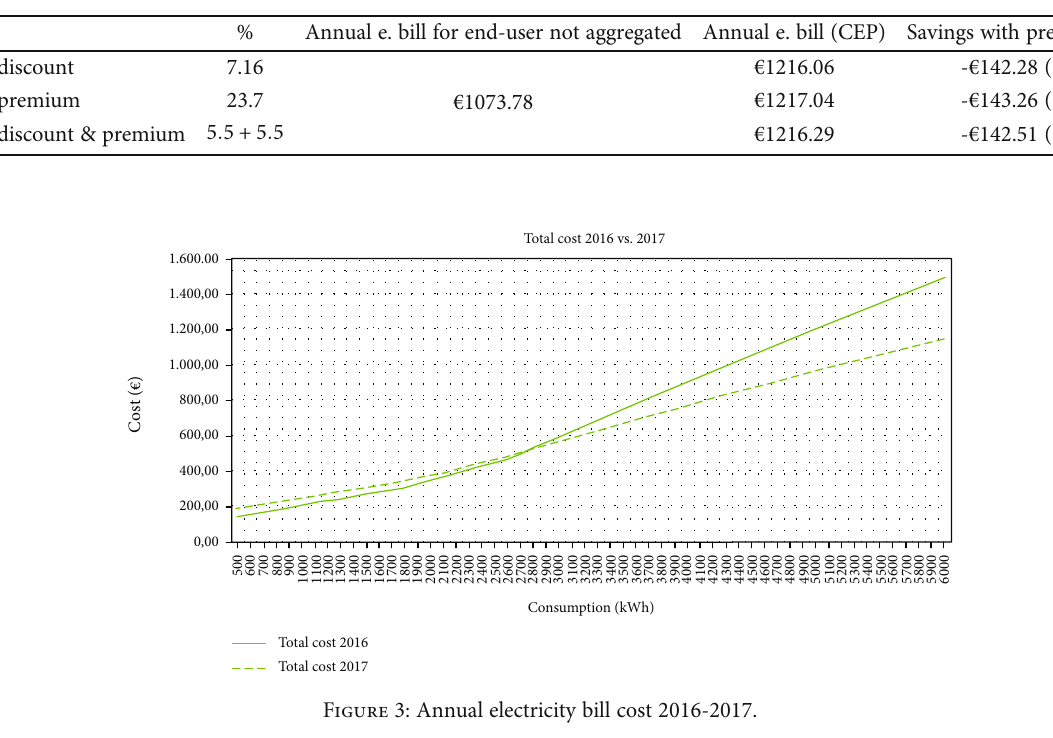
Table 10: Annual electricity bill 2017 with advantages.